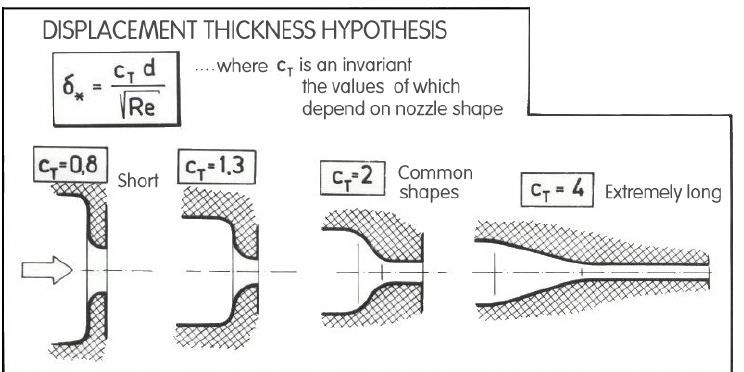
Characterisation invariant c T of nozzles was introduced initially in [1, 9] for nozzles with smooth, rounded internal shape – but it could be later extended to characterise the internal geometry of nozzles in general. Increasing c T value means a longer friction path of the internal flow, the consequence being a thicker boundary layer in the nozzle exit